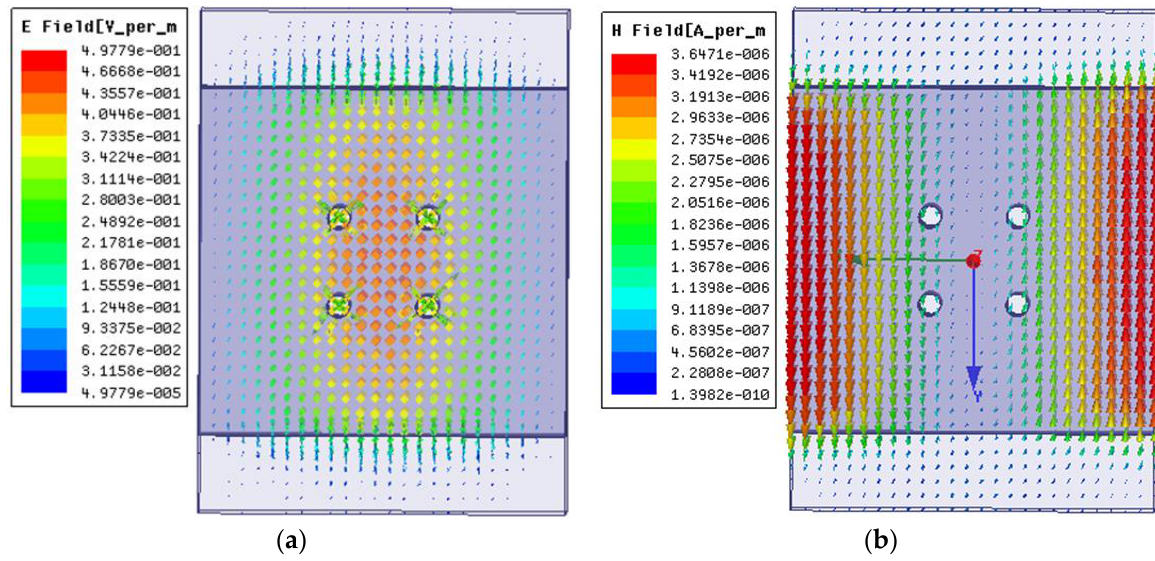
Figure 5. Electric field and magnetic field distribution of the intermediate cavities with HFSS. ( a ) E-field distribution; ( b ) M-field distribution. Table 2. Optimized design parameters (intermediate cavity).